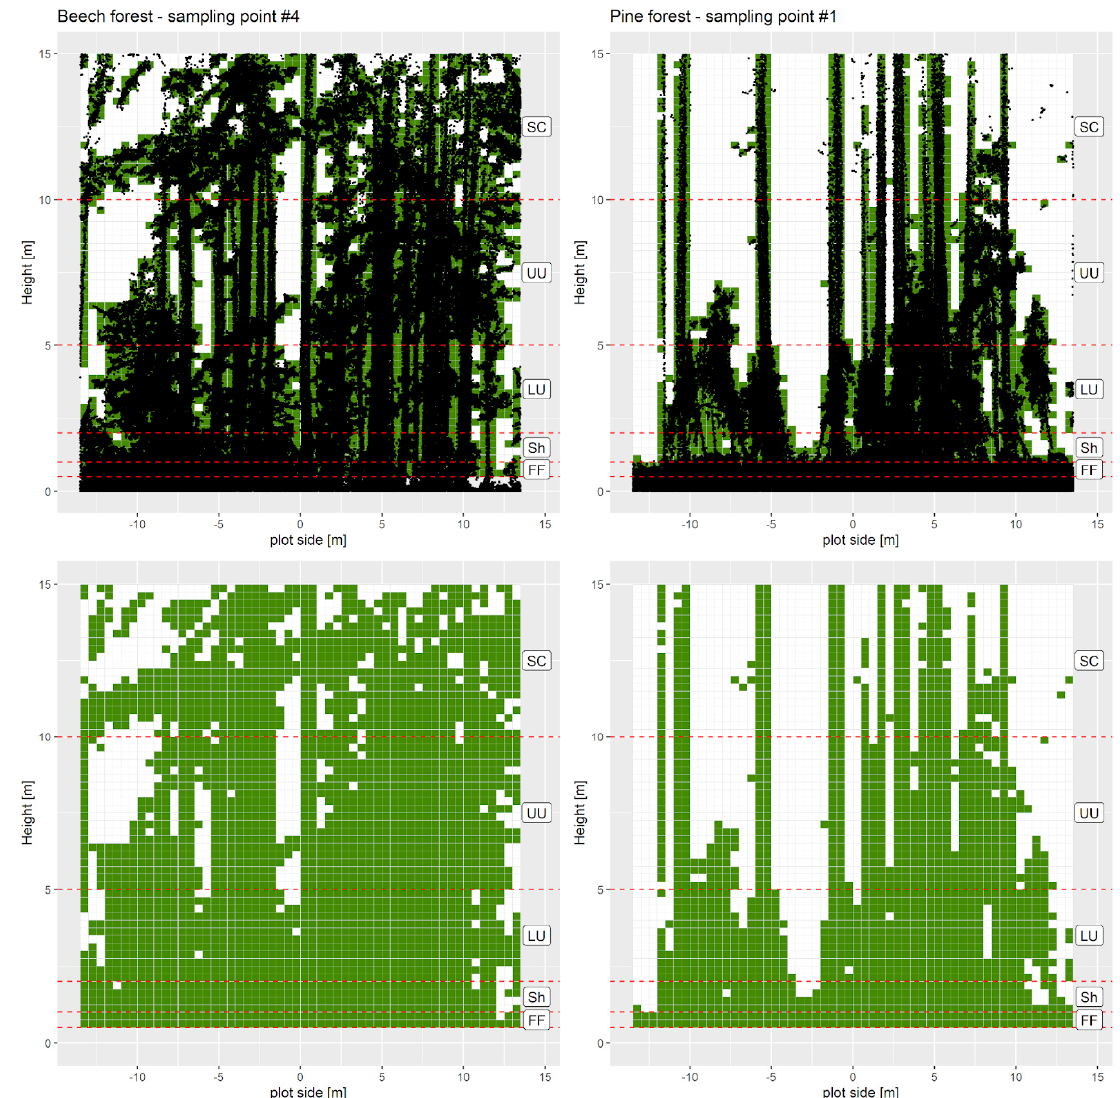
Figure 3. Vertical slice of the TLS–3D space surrounding two example plots. The slice is 10 voxels thick, cut along the central line. Black dots in the upper graphs are cloud points, while in the lower ones, only vegetated voxels are displayed. Voxels (0.5 × 0.5 × 0.25 m) are considered “vegetation” (green) if they contain at least five points. Point cloud is clipped at a height of 0.5 m (to avoid effects from ground vegetation) and 15.5 m (due to the working range of the mobile–TLS). Horizontal dashed lines mark layers’ limits: (FF) forest floor (0.5–1 m), (Sh) shrubs (1–2 m), (LU) lower understory (2–5 m), (UU) upper understory (5–10 m), (Sc) subcanopy (10–15.5